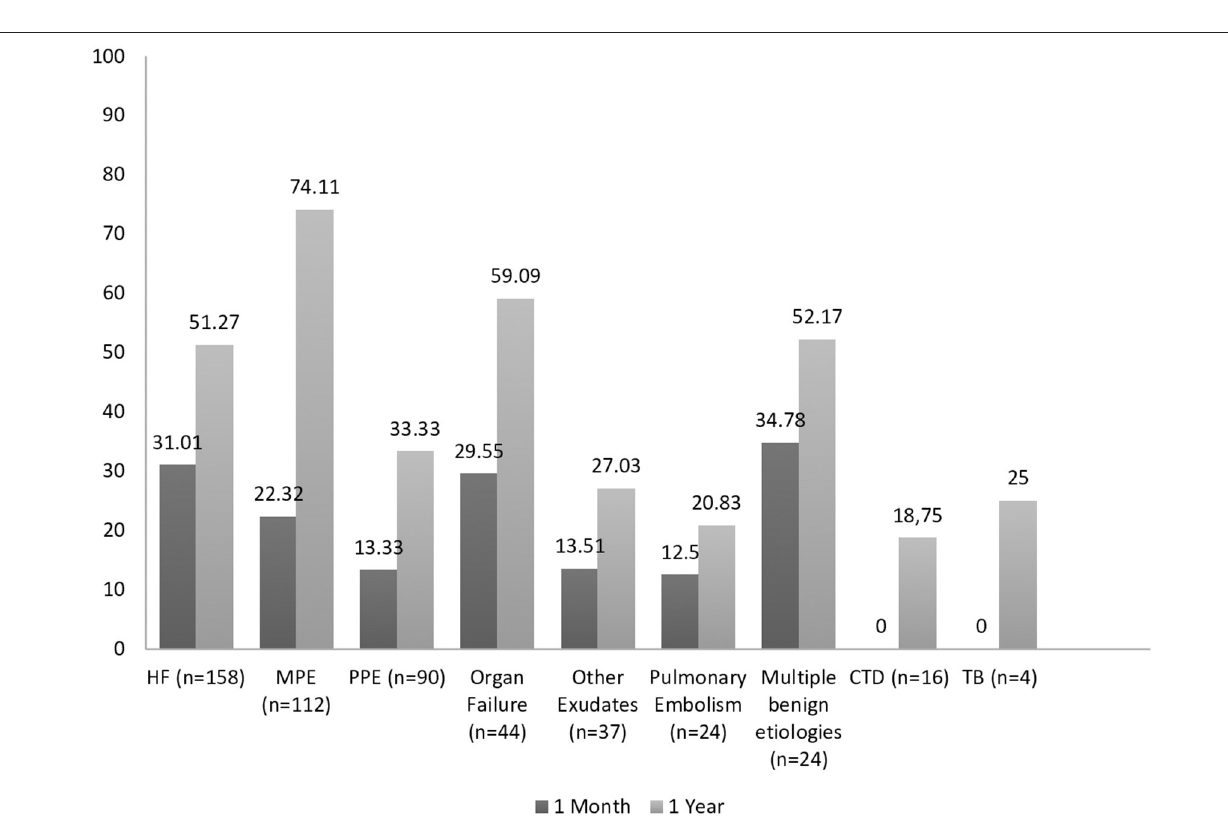
Frontiers in Medicine | www.frontiersin.org